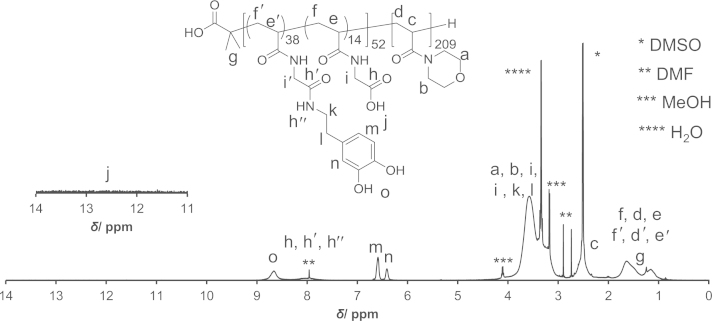
1H NMR spectrum of PAM-PDA polymer (8).